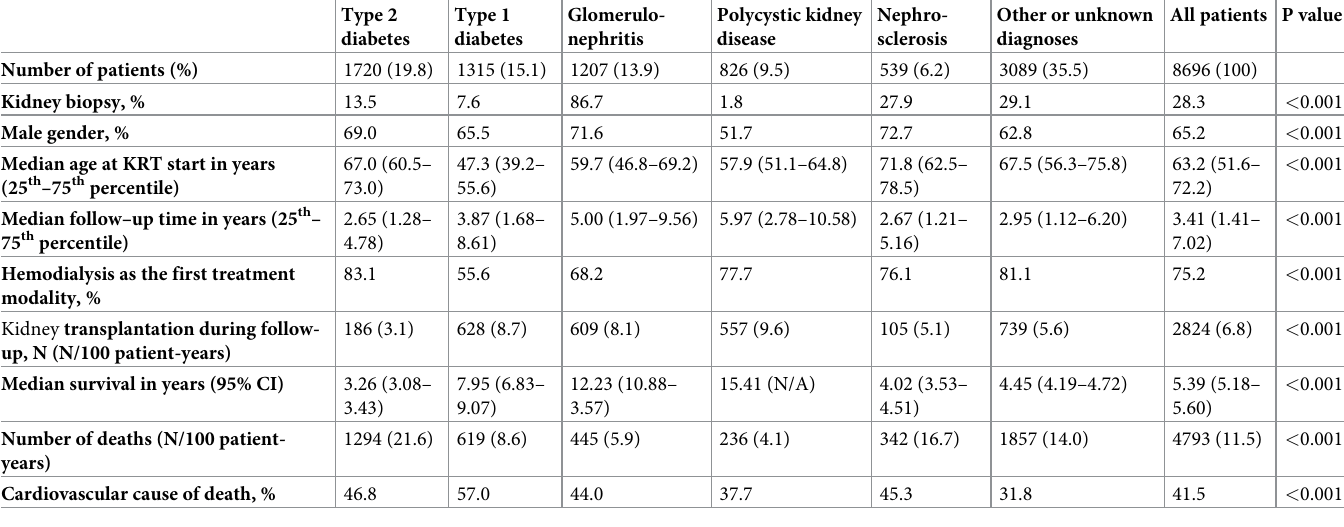
Table 1. Baseline characteristics, follow-up, and survival according to primary kidney disease.